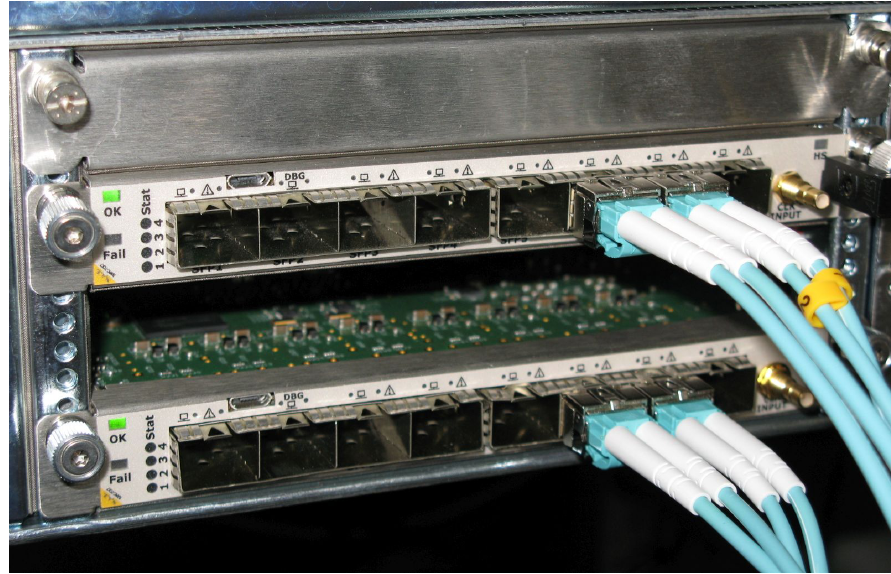
Figure 18. MTCA.4 crate with two installed FPGAs serving as a testbench.